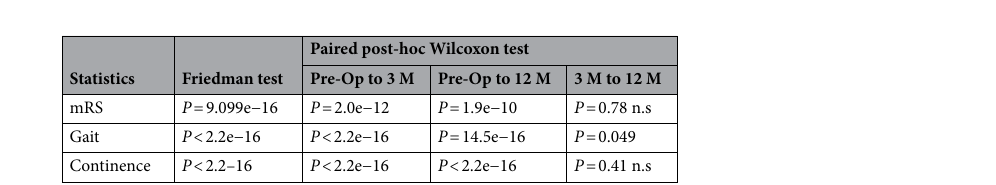
Table 4. Clinical